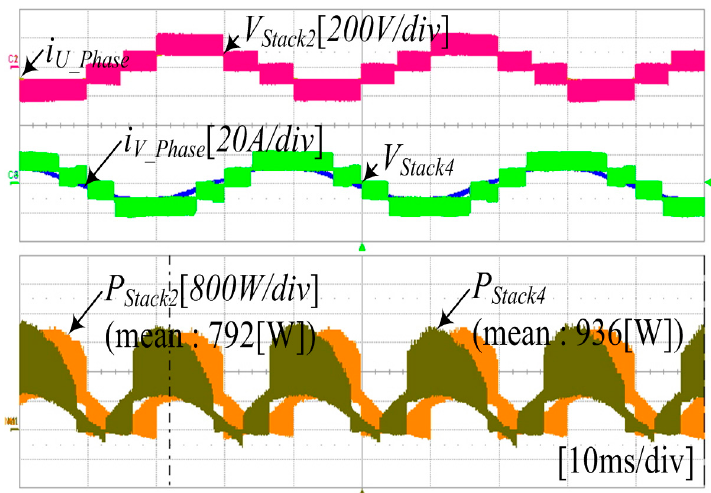
Figure 29. Experimental waveform of output voltage, phase current, and output power of second and